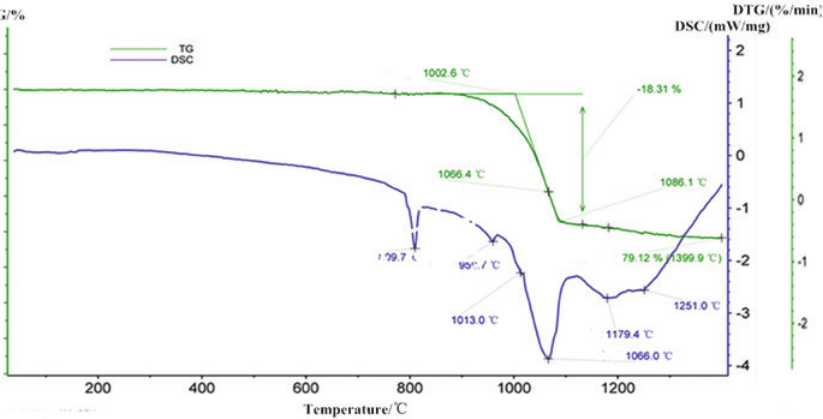
particles prepared under optimal experimental conditions by homogeneous precipitation Figure 9: TG-DSC analysis of BaCO 3